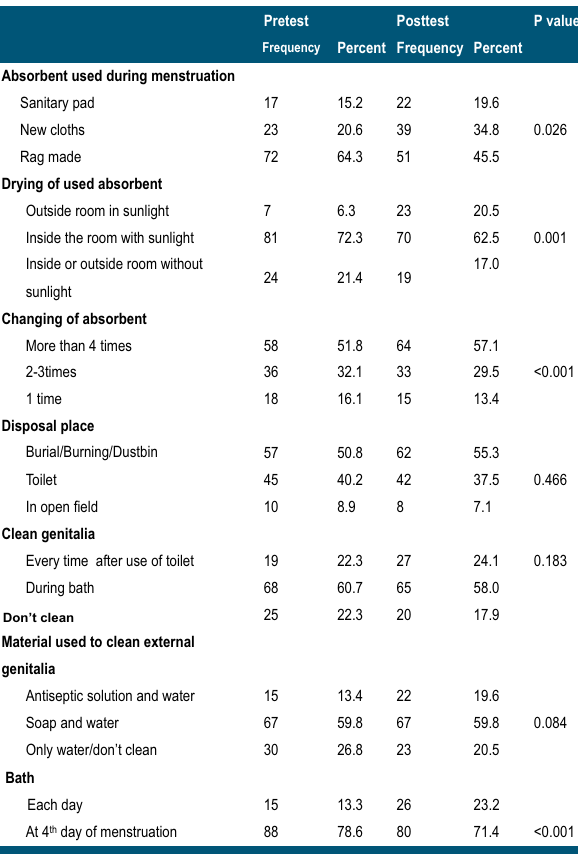
Table 2: Impact of Menstrual Educational Programme on Menstruation Practice. n=112